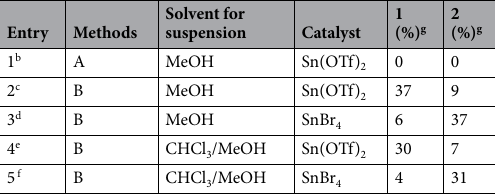
Table 4. Conversion of algae into methyl levulinate ( 1 ) and methyl lactate ( 2 ) using Sn(OTf) 2 or SnBr 4a . a Reaction conditions: methanol (5.0 mL), catalyst (0.24 mmol), naphthalene (0.156 mmol), Ar (5 atm), 24 h, 160 °C. b Catalyst (0.024 mmol). Algae (100 mg) containing 55.5 mg of carbohydrates. c Algae (53.4 mg) containing 29.6 mg of carbohydrates. d Algae (75.2 mg) containing 38.1 mg of carbohydrates. e Algae (78.2 mg) containing 39.6 mg of carbohydrates. f Algae (77.4 mg) containing 39.2 mg of carbohydrates. g Yields (%) of